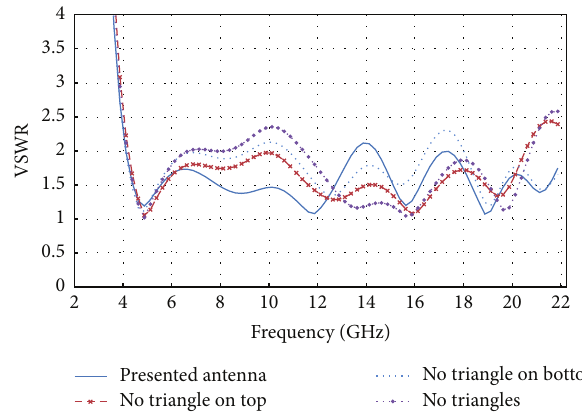
Figure 3: Comparison of VSWR for w/out triangular